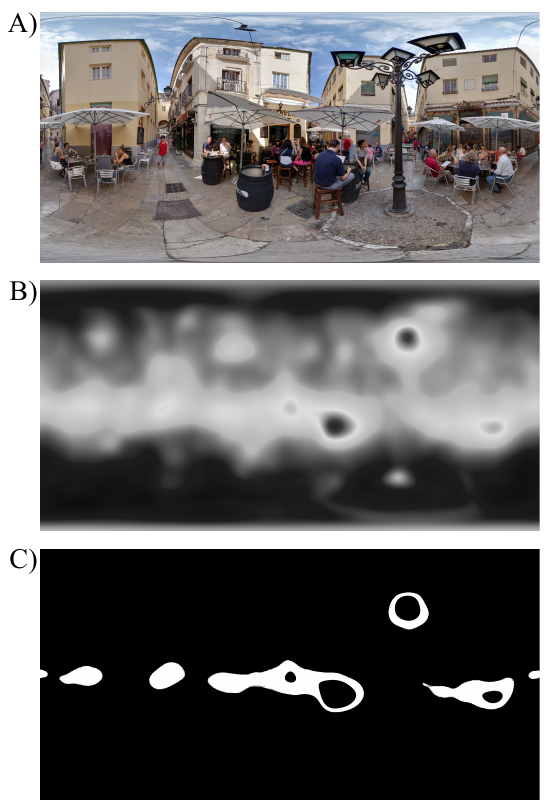
Figure 5. ( A ) Example of one omnidirectional image, ( B ) its saliency map in gray scale, and ( C ) selected 5% most salient pixels indicated by white color. The area of interest is the white region in ( C